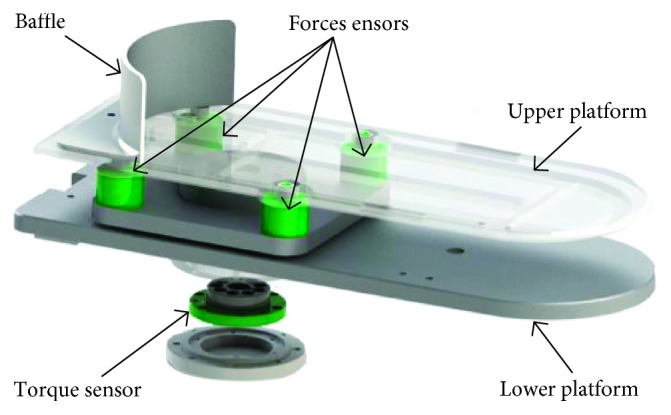
Structure of the moving platform.